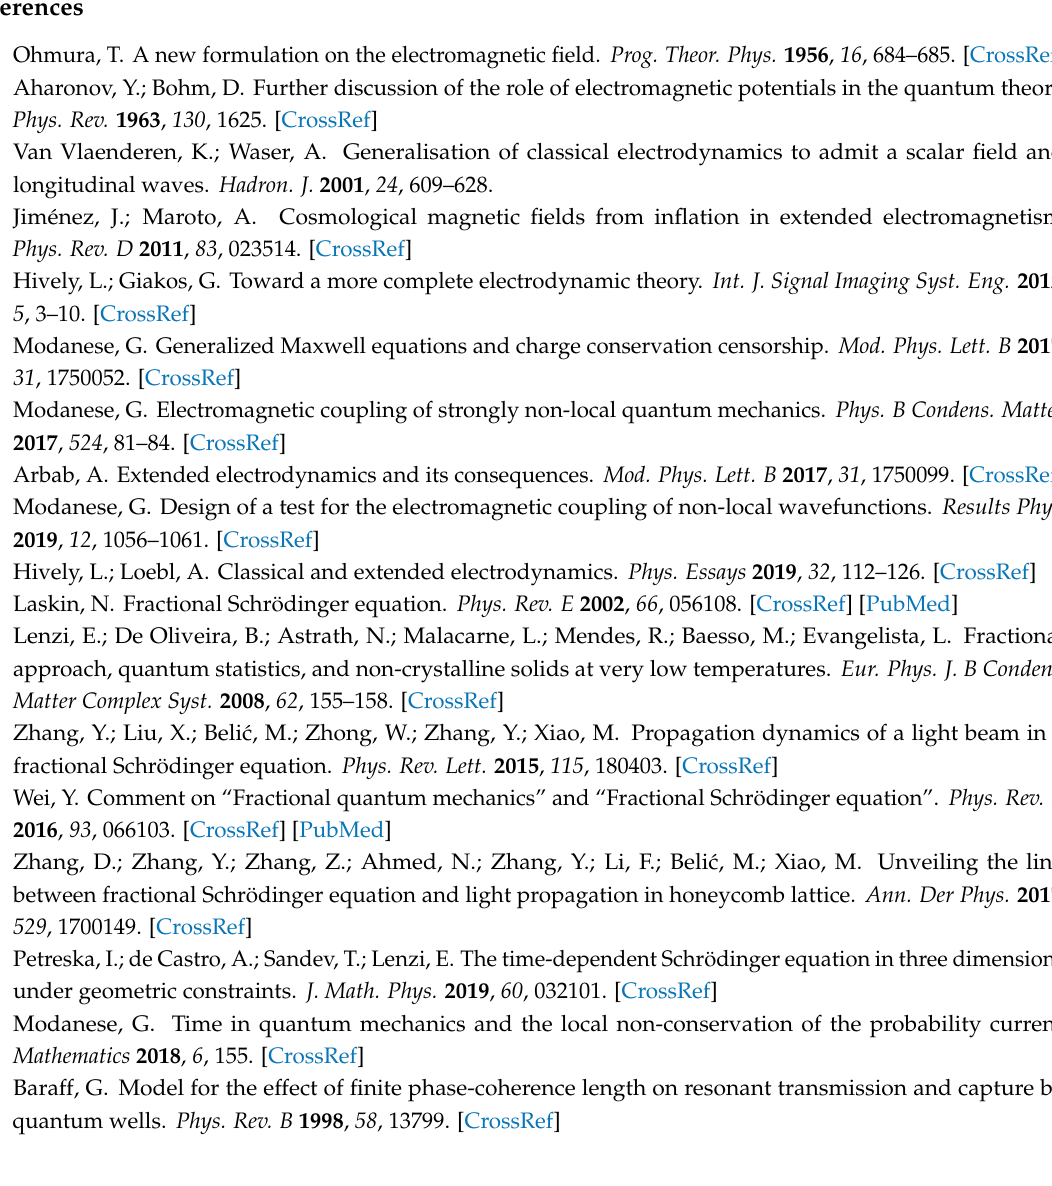
Table A1. Contributions to the longitudinal electric field from the four main integration regions of the y variable in the integrals (41), (52). Data in CGS units, multiplied by 10 6 and referred to a source charge q = 1. For the total field properly normalized to a transverse component see Section 5. The integration regions with y i < 0.1 cm and y i > 100 cm do not give significant contributions. The values of the transverse field are not reported and are typically of the order of 1, in the same units, or less. Integr. Region r = 10 cm r = 10.75 r = 11.5 r = 25 r = 40 [ 0.1,1 ] cm 6 1 − 5 2 1 [ 1,10 ] 144 − 98 − 159 107 60 [ 10,40 ] − 2 − 2 − 3 225 455 [ 40,100 ] 0 ± 1 0 ±